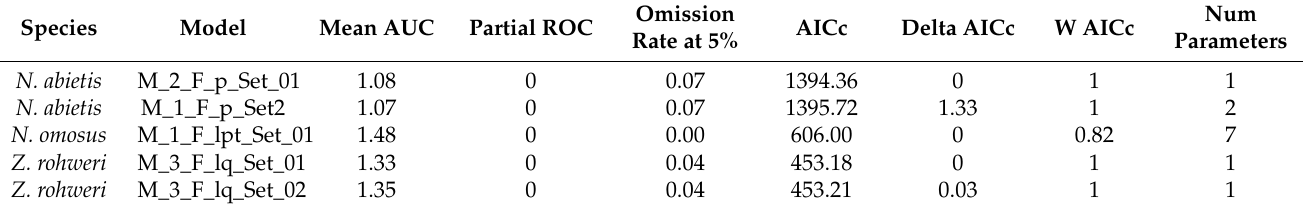
Table 2. Parameter values used to define ecological niche models of three species of sawflies